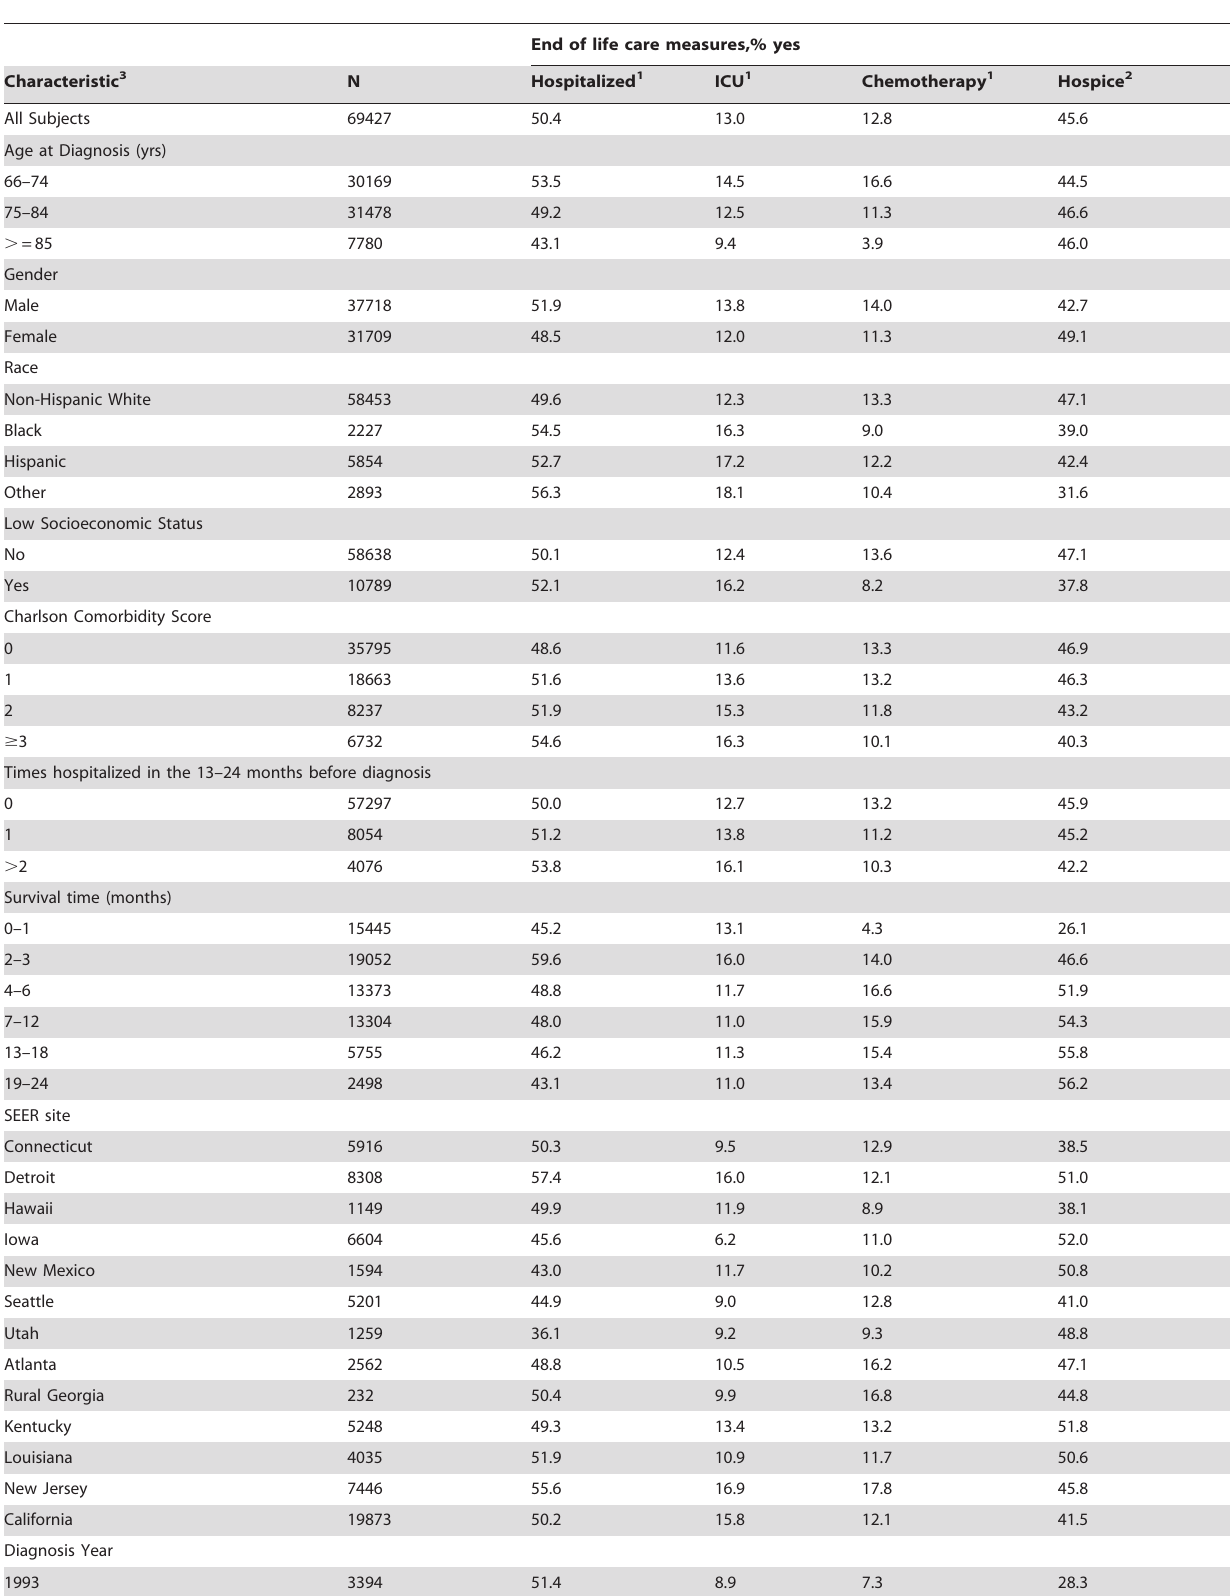
Table 1. Baseline characteristics and percent of patients experiencing end of life care measures in Medicare patients with advanced lung cancer, 1993–2005.